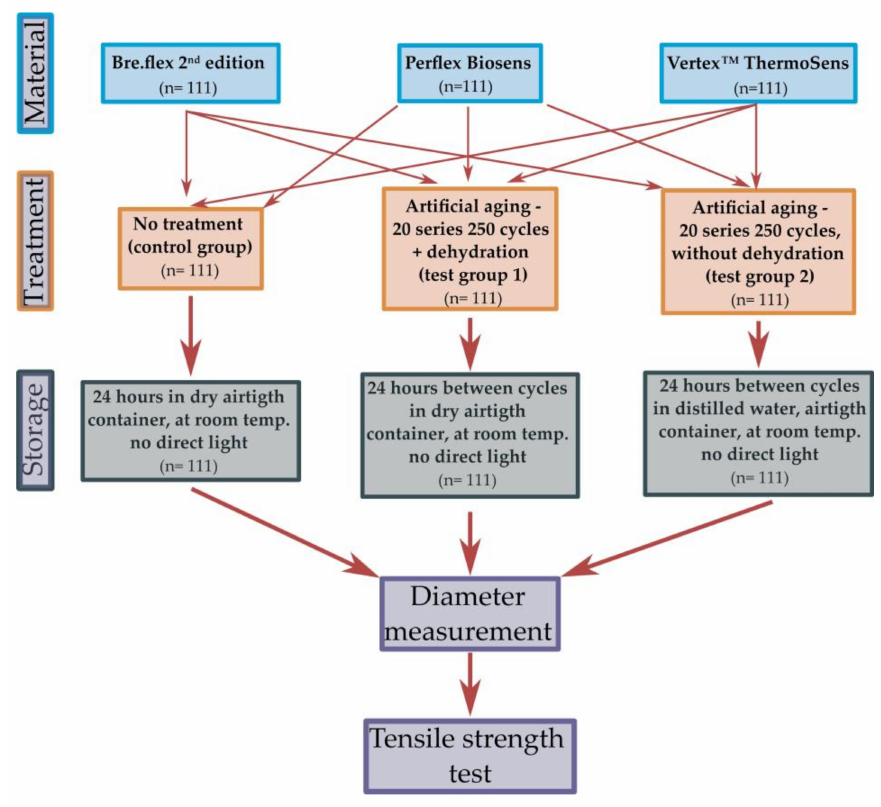
Figure 1. Study design flow-chart.